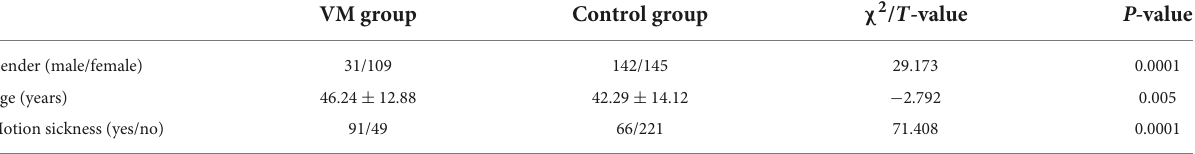
TABLE 1 Clinical data of the VM and control groups.